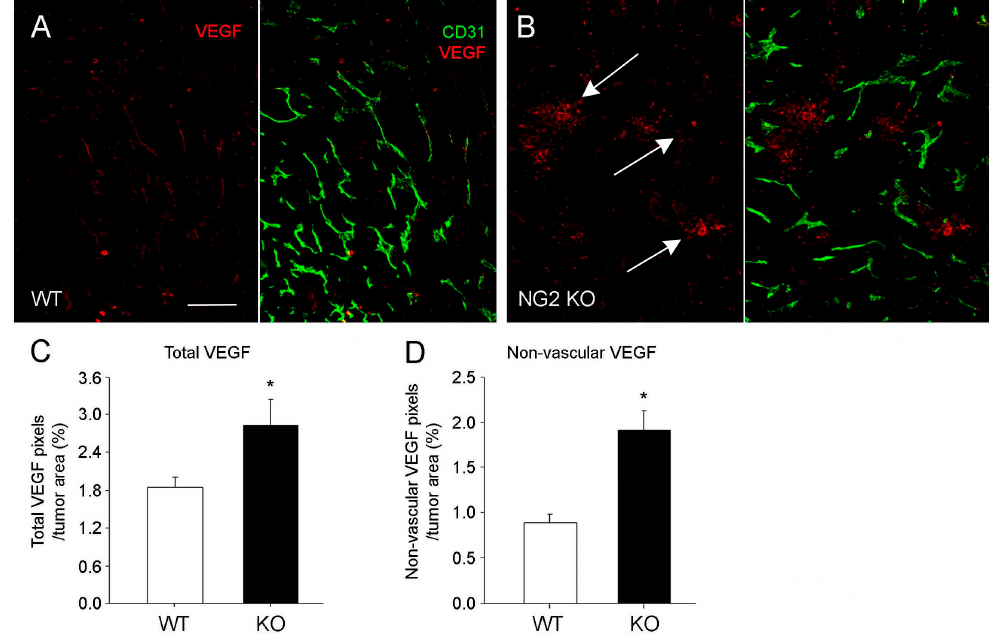
Figure 4. Localization of VEGF-A expression in mammary tumors. Double immunolabeling for CD31 (green) and VEGF-A (red) was used to localize VEGF-A expression relative to mammary tumor blood vessels in control ( A ) and NG2 null ( B ) mice. Total VEGF-A is elevated in tumors in NG2 null mice ( C ), but this increase is due to an increase in non-vascular VEGF-A ( D ). In tumors in control mice, VEGF-A expression is largely associated with the vasculature, while more diffusely localized VEGF-A is evident in tumors in NG2 null mice (arrows in B). * p < 0.01. Scale bar: 60 μ m. Data taken from Gibby, et al. [31].